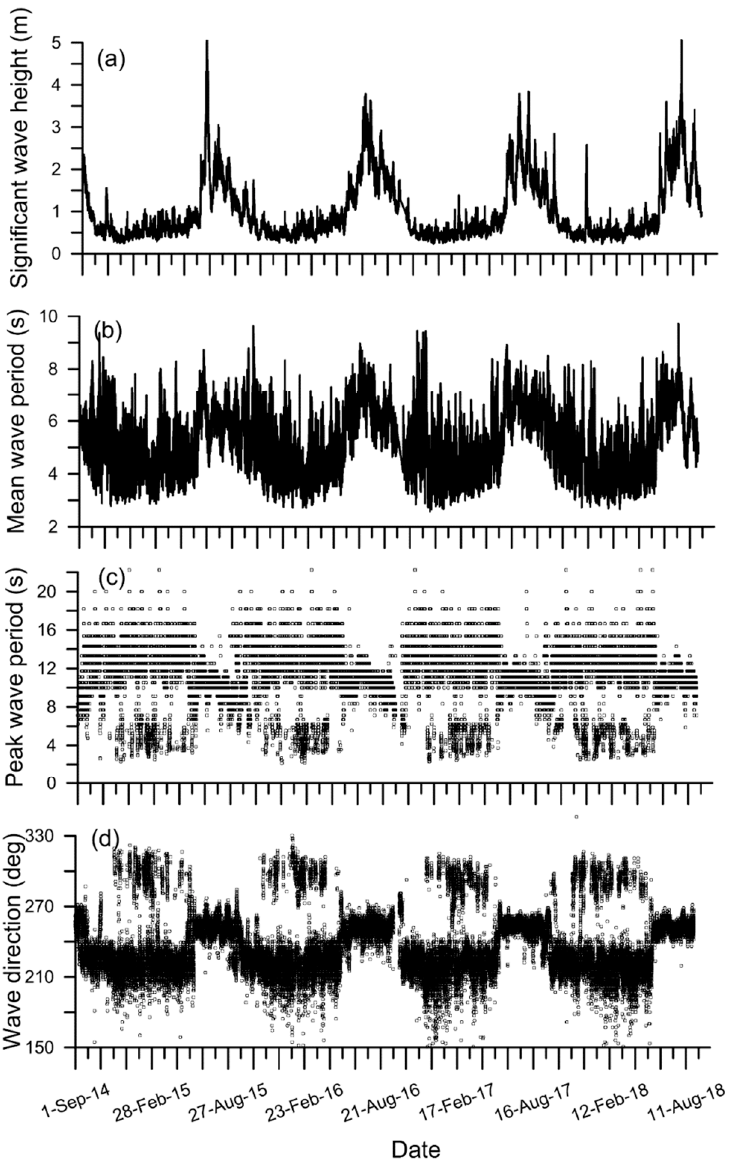
Figure 2. Time series plot of ( a ) significant wave height, ( b ) mean wave period, ( c ) peak wave period and ( d ) mean wave direction from 1 September 2014 to 31 August 2018 at 15 m water depth.